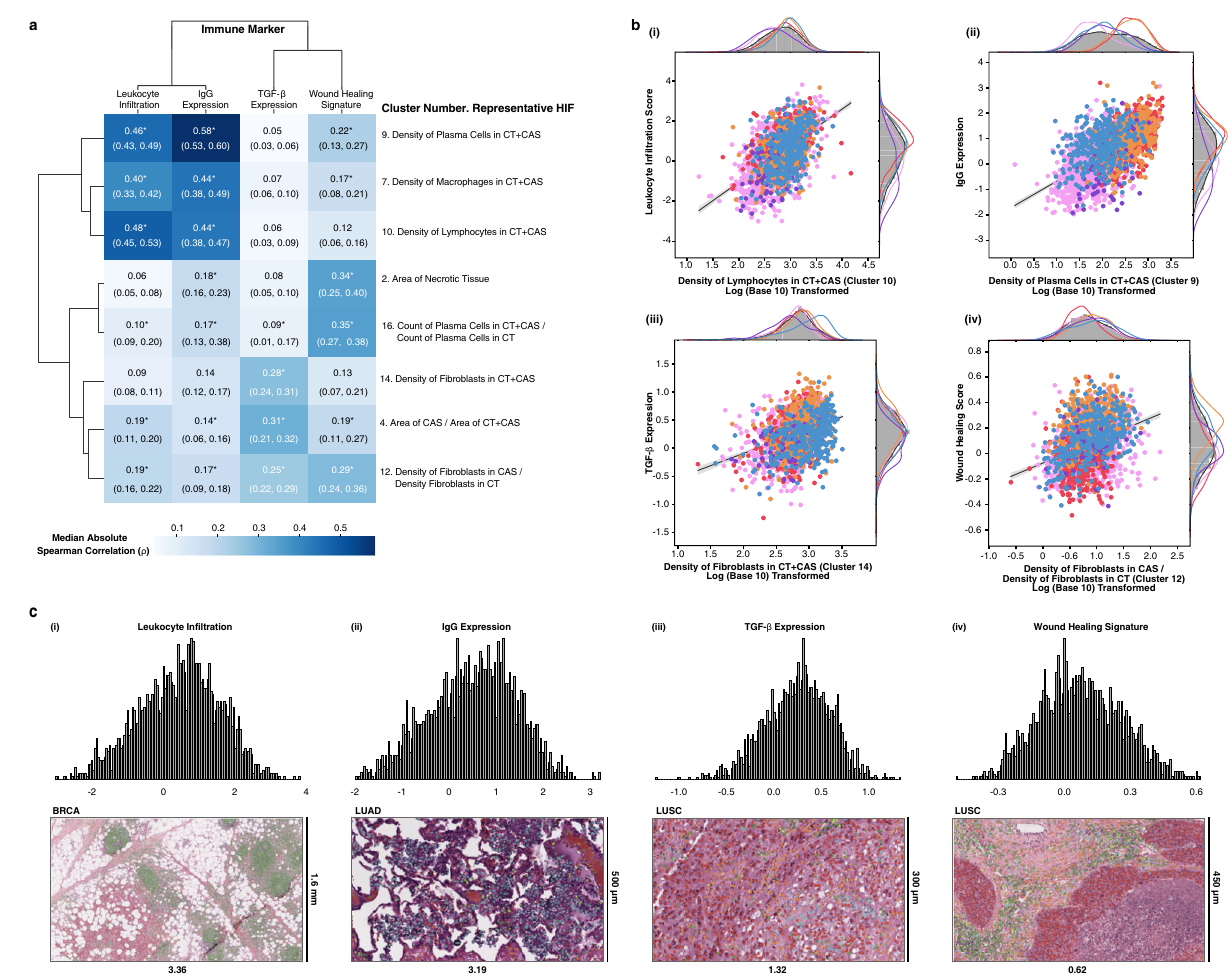
Fig. 5 Validation of HIFs against immune signatures. a Clustered heatmap of median absolute Spearman correlation coef fi cients ( ρ ) computed across all patient samples between eight clusters of human-interpretable image features (HIFs) (de fi ned pan-cancer) and four canonical immune signatures. P values were computed using a two-sided test for whether the correlation coef fi cient was signi fi cantly different from 0. Hierarchical clustering was done using average linkage and Euclidean distance. Median absolute Spearman correlation coef fi cients with a combined (via the Empirical Brown ’ s method) and corrected (via the Benjamini – Hochberg procedure) P value lower than the machine precision level (10 − 30 ) are annotated with an asterisk. Negative control analyses are included in Supplementary Table 3. Tumor regions include cancer tissue (CT), cancer-associated stroma (CAS), and a combined CT + CAS. b Correlation and kernel density estimation plots between representative HIFs and immune signatures. Points are colored by cancer type (same schema as Fig. 4a). X -axes are log-transformed (base ten). Trendlines are plotted on the log-transformed data. Cell densities are reported in count/mm 2 and tissue areas are reported in mm 2 . c Histogram of immune signature expression ( Z -score) across all patients, alongside a histological snapshot with its cell-type heatmap overlaid corresponding to high expression of the given immune signature. Cell-type heatmaps adhere to the same color scheme described in Fig. 1c. Histological snapshots have dimensions (from left to right, width by height) of 12,479 × 7109, 4230 × 2408, 4230 × 2408, and 5286 × 3016 μ While our HIF generation process explicitly encodes Fig. 11) and computed cluster-level P values to evaluate sig- for interactions between biological entities (e.g., count of ni fi cance (Supplementary Table 8; “ Methods ” ). lymphocytes within 80 μ m of fi broblasts), we also compared As expected, prediction of PD-1 and PD-L1 involved similar and achieved comparable hold-out AUROC and AUPRC HIF clusters (Pearson correlation between PD-1 and PD-L1 performance between our HIF-based linear models against HIF- expression = 0.53; Supplementary Fig. 12). For example, the based random forest models, which directly account for extent of tumor in fl ammation, as measured by the count of interaction effects between HIFs (Supplementary Table 7). cancer cells within 80 μ m of lymphocytes, as well as the density of lymphocytes in CT + CAS, was signi fi cantly selected during model fi tting for both of PD-1 and PD-L1 expression in pan- cancer and BRCA models (Fig. 6bi, ii and Supplementary Fig. 11i, ii). Furthermore, in both LUAD and LUSC, the count of lymphocytes in CT + CAS was similarly predictive of PD-1 and PD-L1 expression. The importance of these HIFs that capture lymphocyte in fi ltration between and surrounding cancer cells corroborates prior literature, which demonstrated that TILs by magnitude of model coef fi cients (Fig. 6b and Supplementary